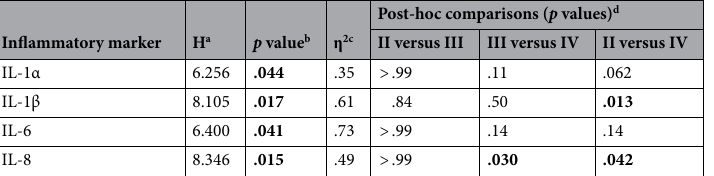
Table 3. Differences in tumor inflammatory marker concentrations as a function of WHO grade. IL interleukin. a Non-parametric Kruskal–Wallis H-test. b Bolded values indicate statistical significance ( p ≤ .05). c Effect size was calculated using η 2 . d p values adjusted using the Bonferroni correction for comparing tumor grade within inflammatory marker.